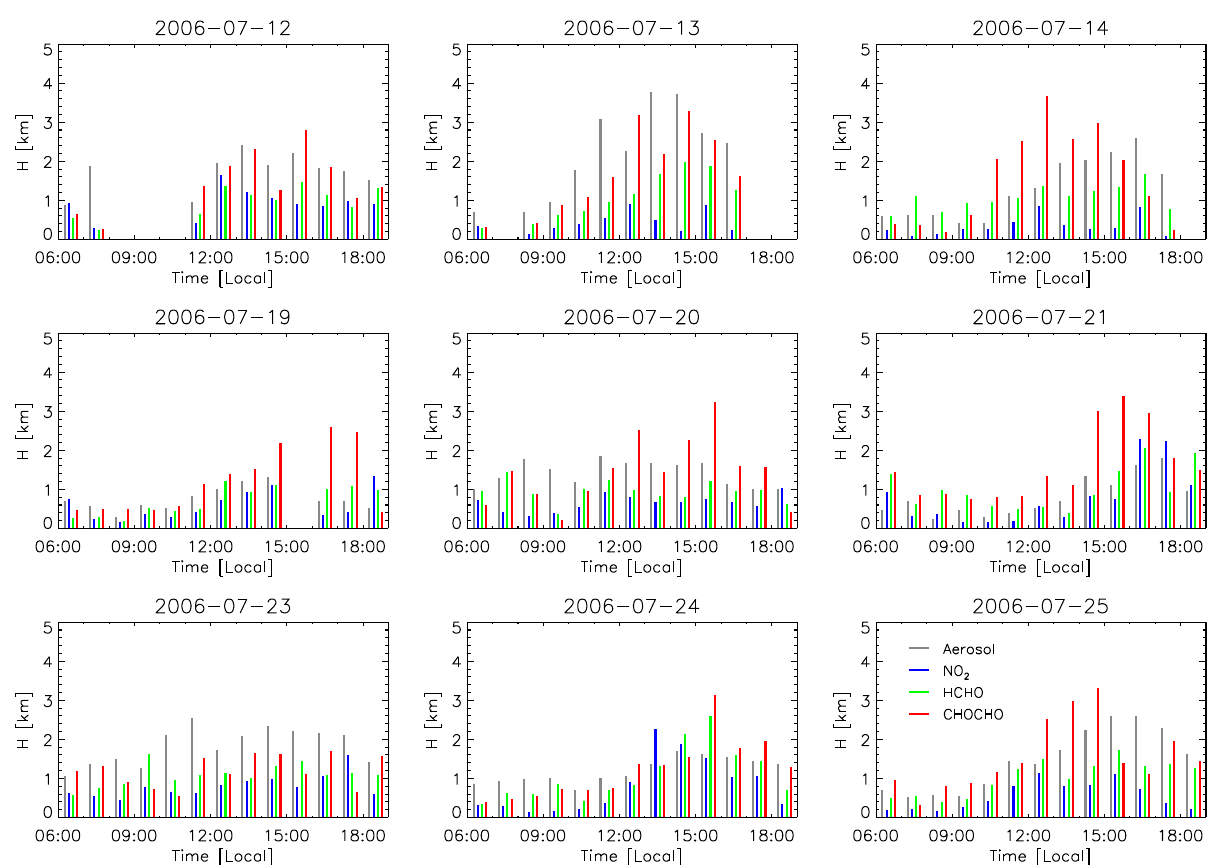
Fig. 6. Time series of mixing layer heights of NO 2 , HCHO, CHOCHO and aerosol extinction (cf. Li et al., 2010) on the 9 cloud-free days during the PRIDE-PRD2006